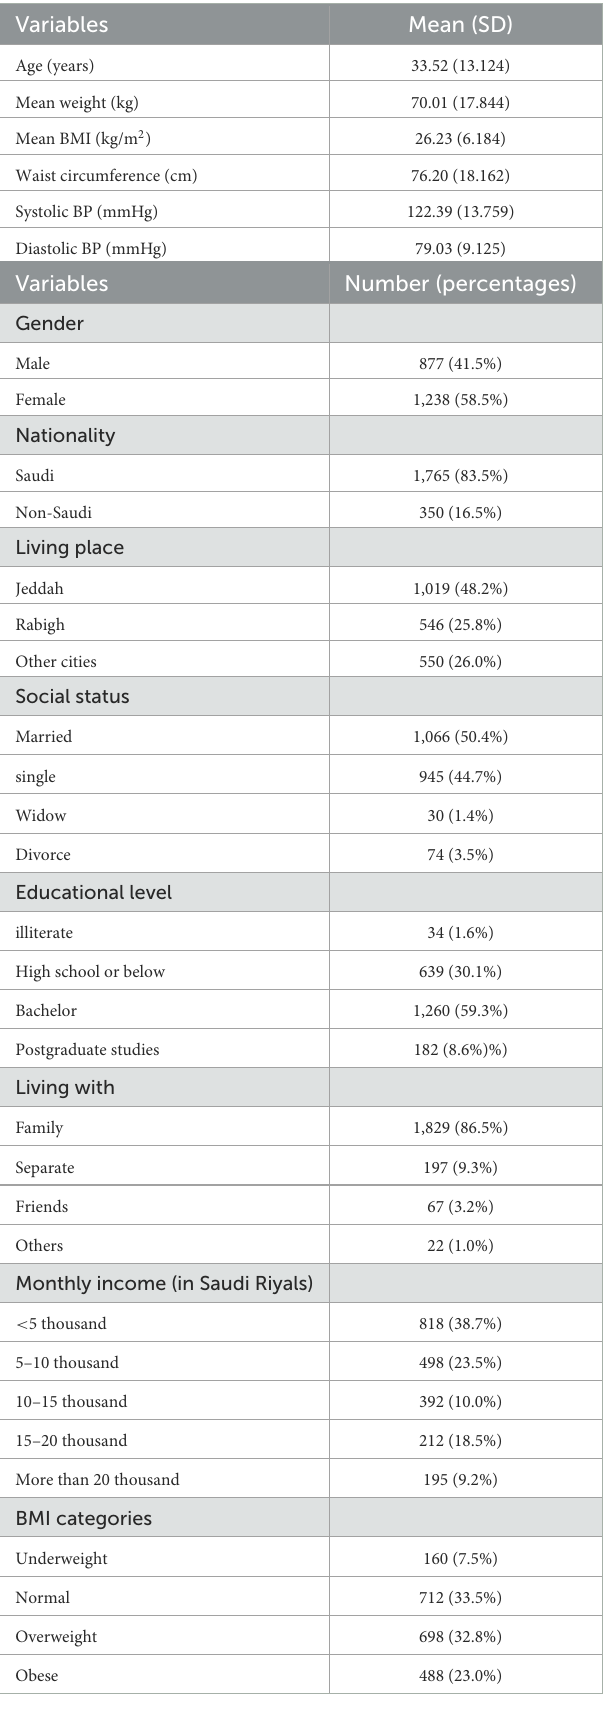
TABLE 1 General characteristics of the study participants ( n =